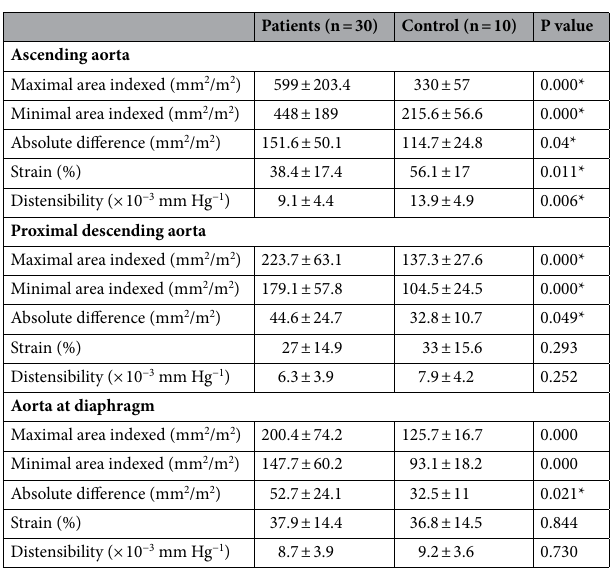
Table 2. Comparison of cardiac MRI parameters between patients and